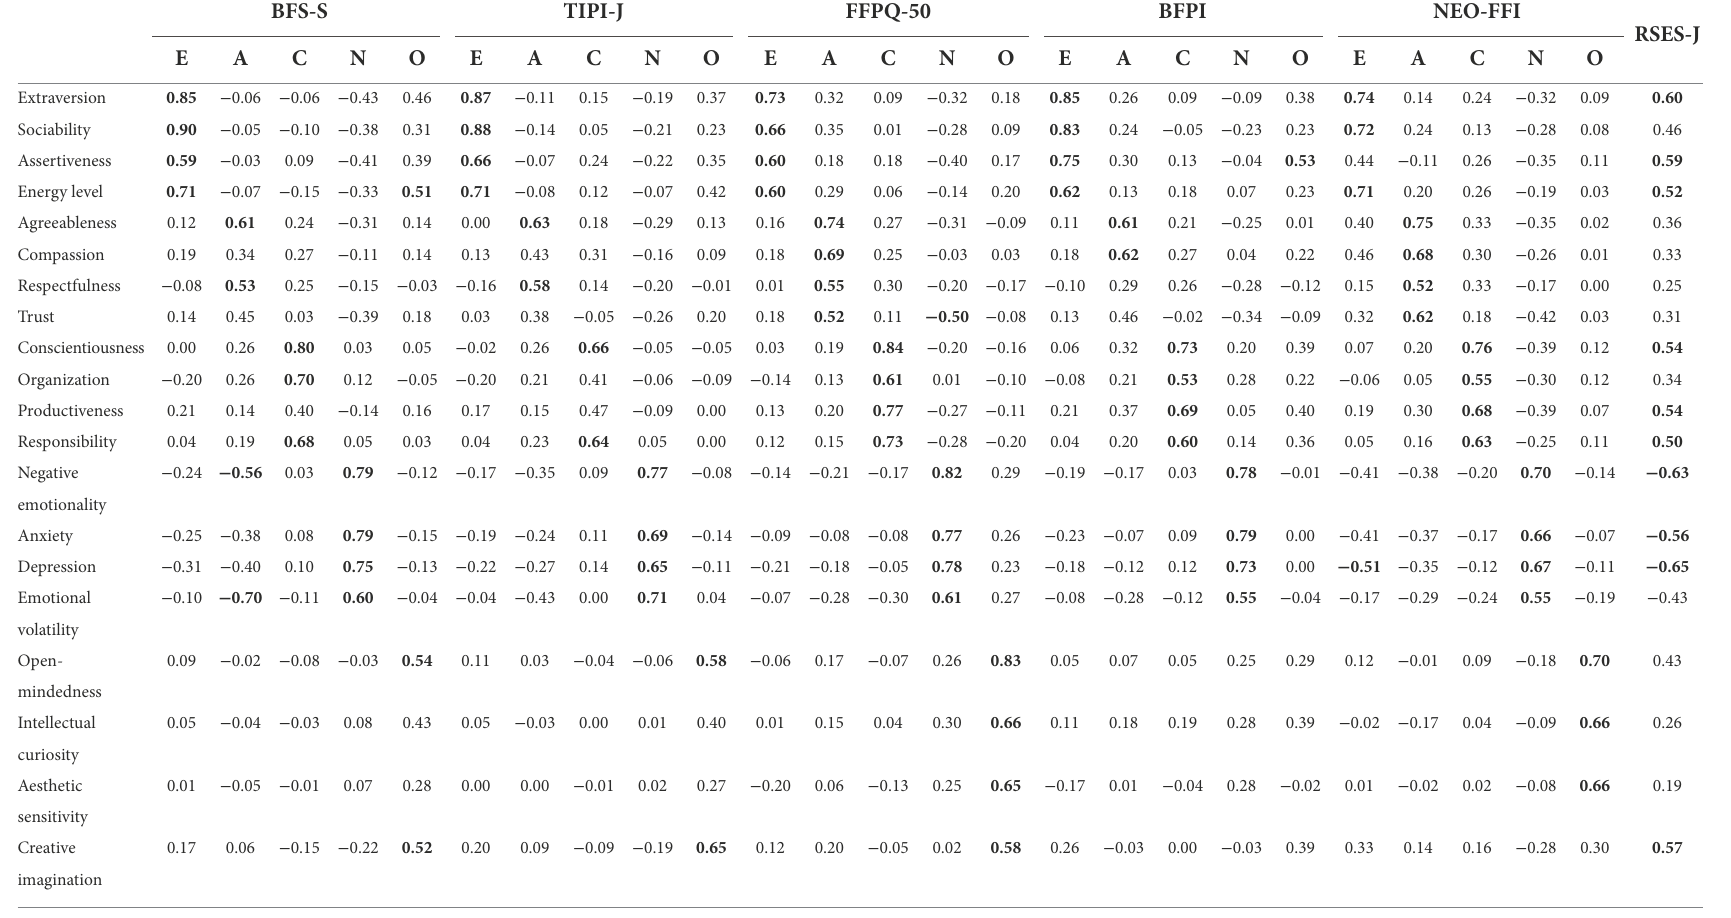
TABLE 6 Correlations of the BFI-2-J with the BFS-S, TIPI-J, FFPQ-50, BFPI, NEO-FFI, and